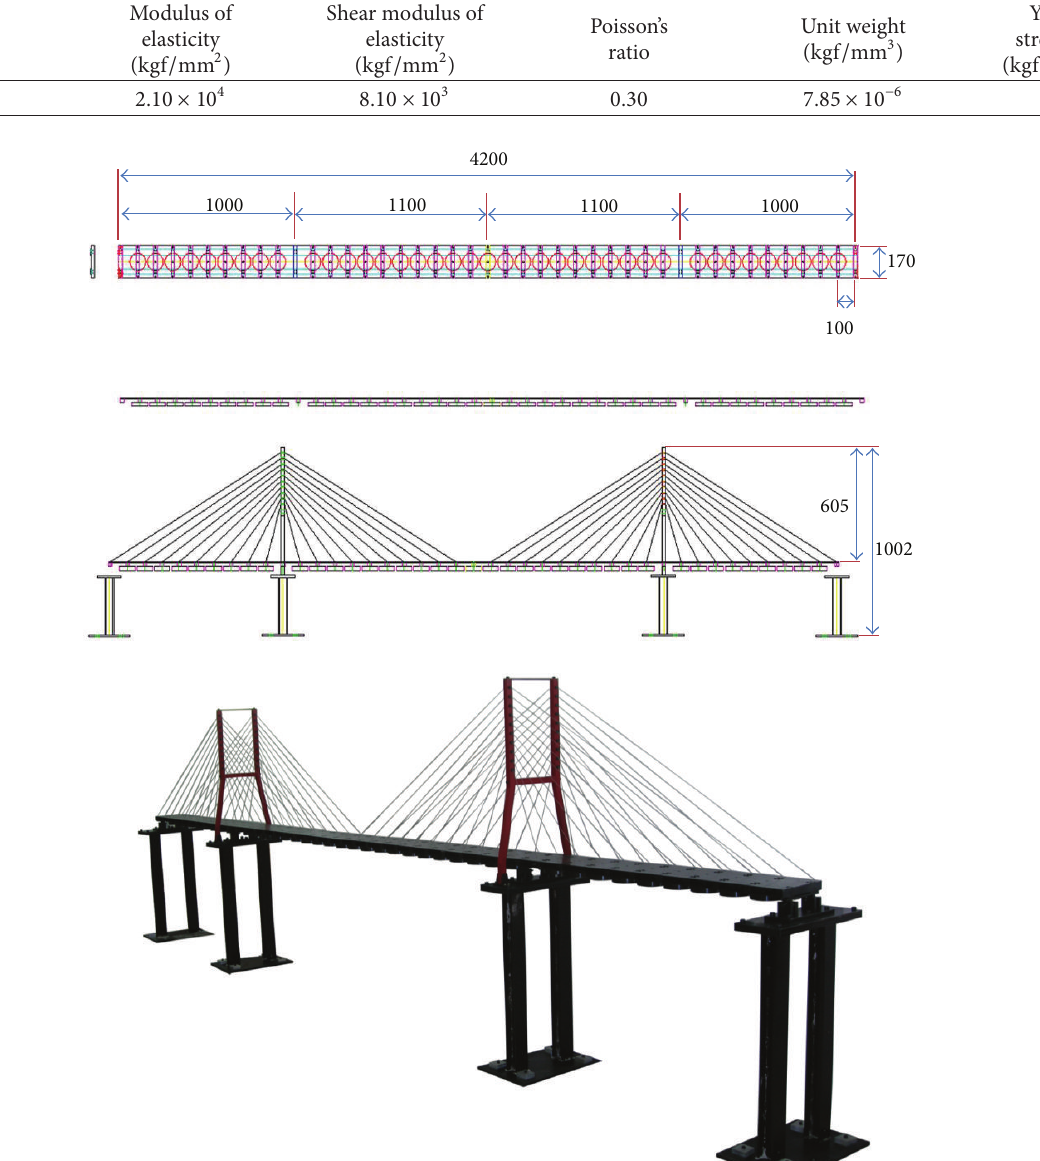
Figure 1: View of the cable-stayed bridge